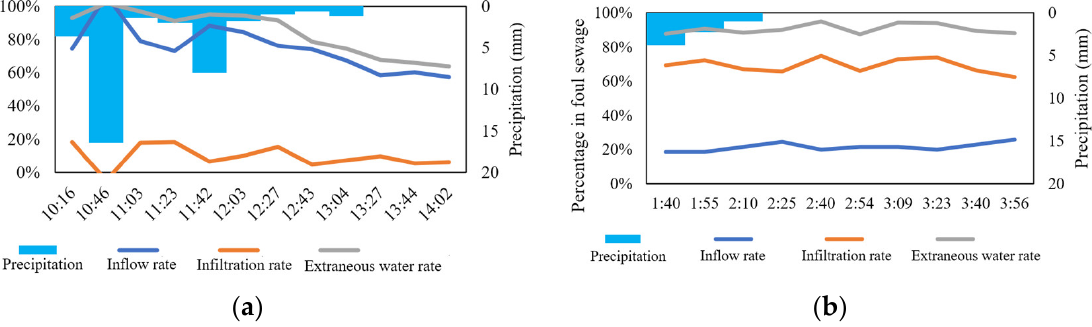
Table 3. Parameters of the I/I model for inflow in each sewage area. Figure 7. Analysis result of minutely I/I rates of sewage network at a typical site (S1) during rainfall periods. ( a ) 17 August 2018 (36 mm precipitation). ( b ) 22 August 2018 (7 mm precipitation).